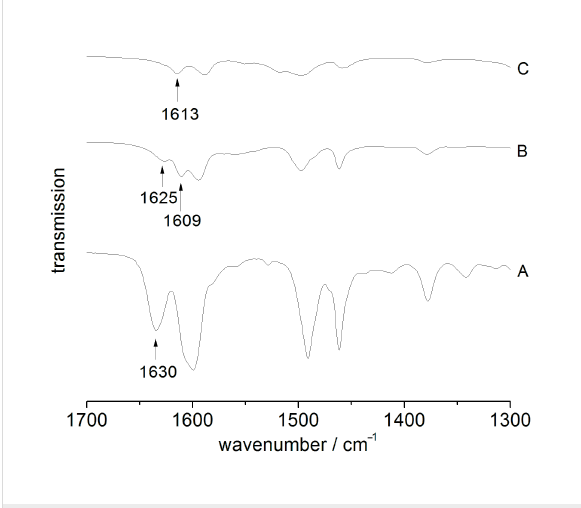
Figure 2: C=O vibrational band section of the infrared spectra of com- pound 1 (A), MCM-ACR (B) and MCM-ACR + Sc(OTf) 3